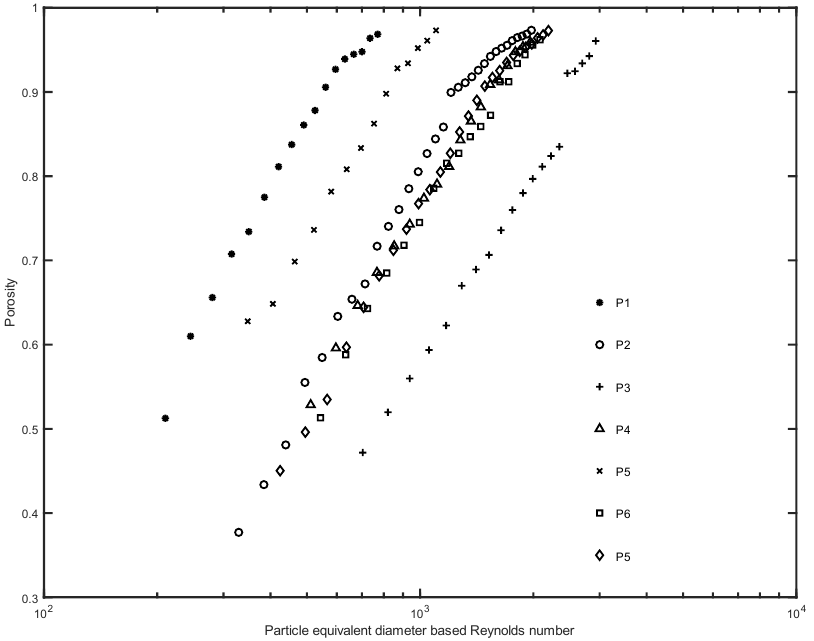
Figure 6. Porosity as a function of particle Reynolds number for a range of particles of varying density, size and sphericity.